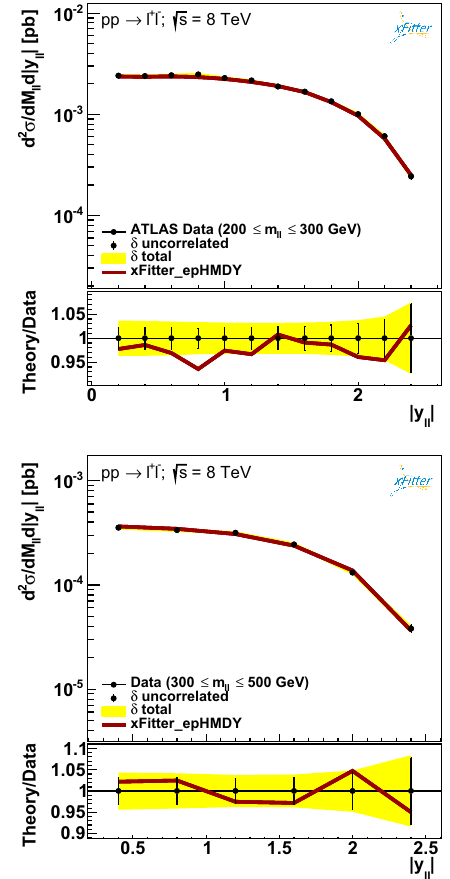
Fig. 6 Upperplot Comparisonbetweenthephoton x γ( x , Q 2 ) at Q 2 = 10 4 GeV 2 from the present NNLO analysis ( xFitter_epHMDY )with the corresponding results from NNPDF3.0QED, LUXqed and HKR16. Lower plot The same comparison, now with the results normalised to the central value of xFitter_epHMDY . For the present fit, the PDF uncertainties are shown at the 68% CL obtained from the MC method, while model and parametrisation uncertainties are discussed below. For HKR16 only the central value is shown, while for LUXqed the associated PDF uncertainty band [7] is